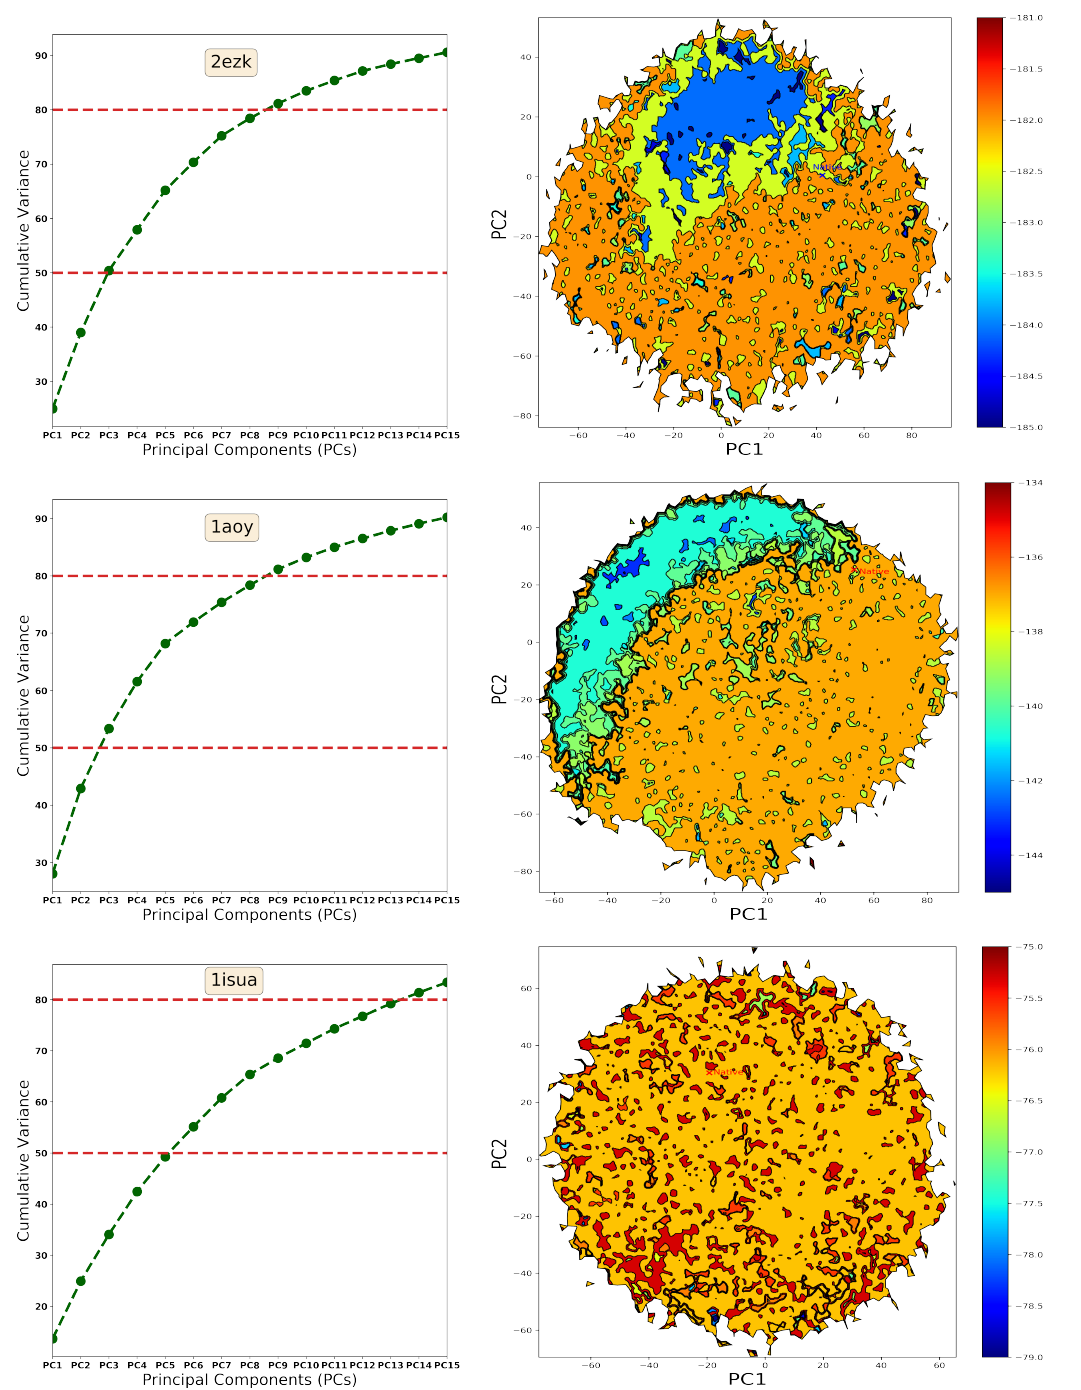
Figure 5. Results are shown the hard targets. The left panel shows the accumulation of variance for the PCs obtained from PCA of generated decoys. The right panel shows the reconstructed landscape over the PC1-PC2 grid. The contour lines show the basin boundaries. The location of a known native structure for each target protein from the easy category highlighted here is marked by a red